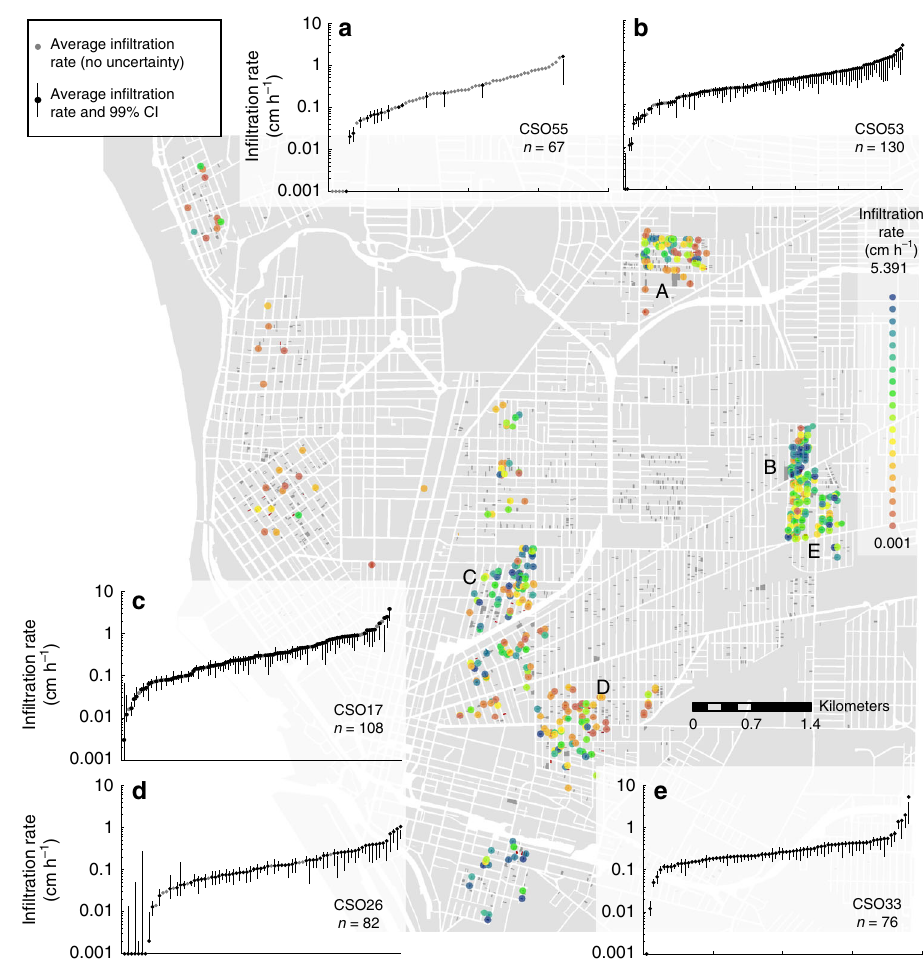
Fig. 1 Average parcel in fi ltration rate ( n = 520) across Buffalo, NY (USA). Inserts display distributions of in fi ltration rates for fi ve sewersheds, including a CSO 55 ( n = 67), b CSO 53 ( n = 130), c CSO 17 ( n = 108), d CSO 26 ( n = 82), and e CSO 33 ( n = 76) with associated uncertainty estimates as 99% con fi dence intervals for a subset of sites ( n =